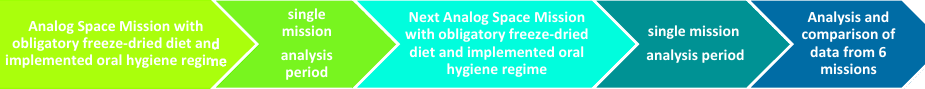
Figure 5. Methodology of data collection and analysis .